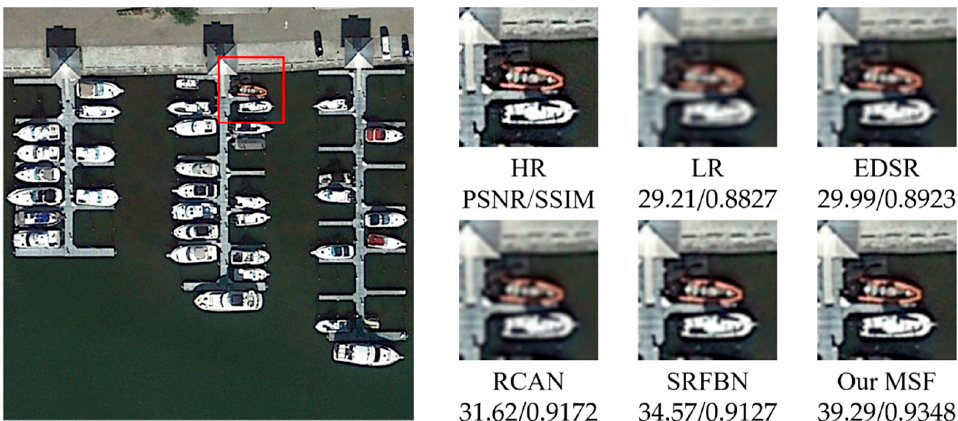
Sensors 2021 , 21 , x FOR PEER REVIEW Figure 6. Qualitative comparison between different SR models performance on plane instance-class.